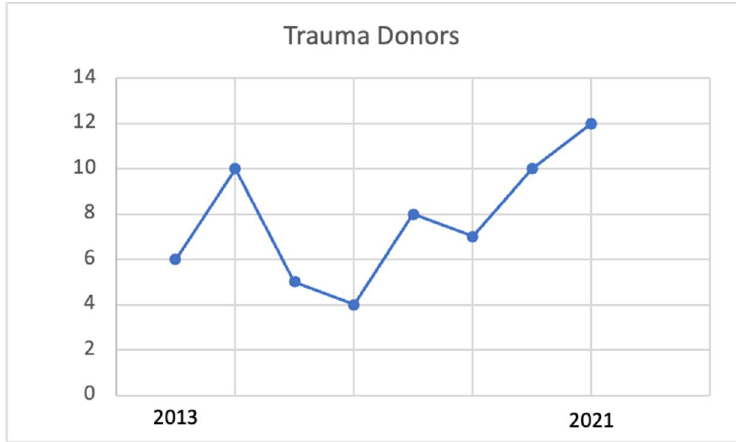
Figure 2. Distribution among years of traumatic liver donors at ASST GOM Niguarda.